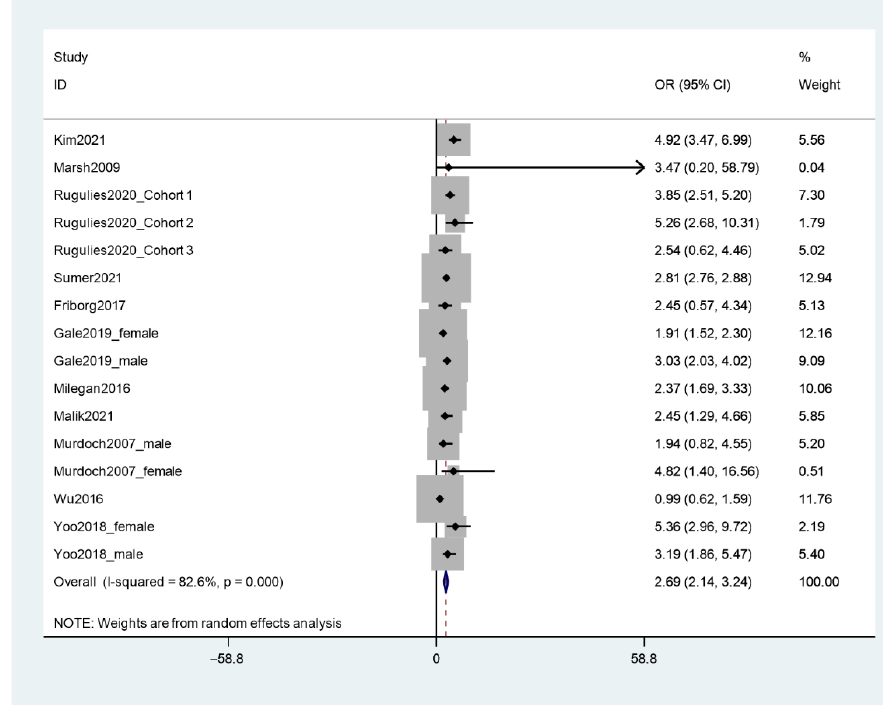
enced or who was the perpetrator (see Table 1).